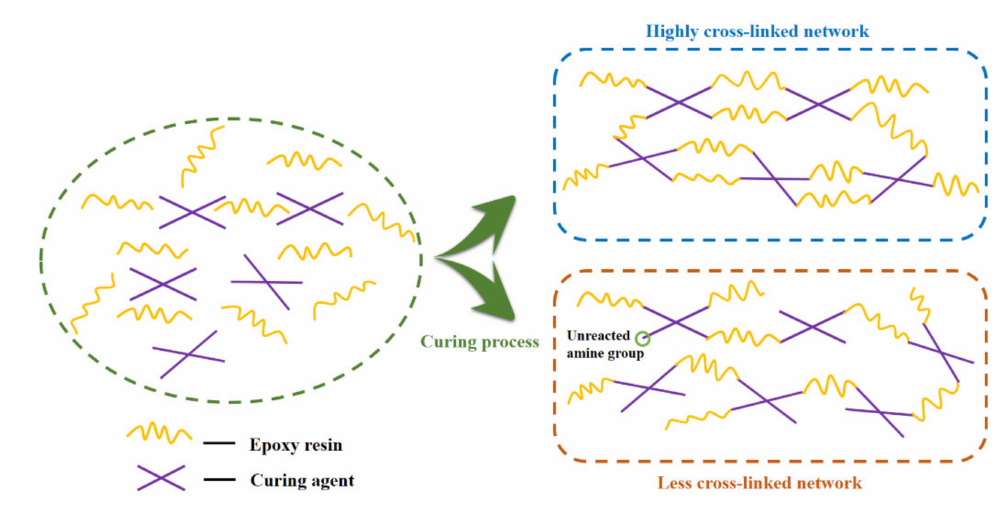
Figure 9. Schematic of the two types of crosslinking systems in the cured vanillyl alcohol–based